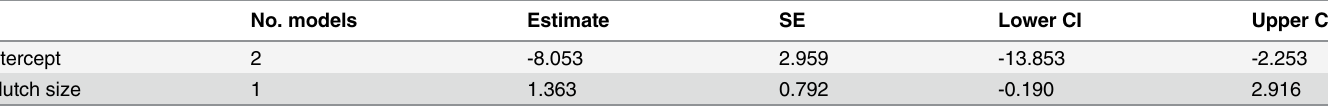
Table 3. Averaged model estimates and 95% confidence intervals from the top models predicting egg stage failure (marginal R 2 = 0.22; conditional R 2 = 0.22); b); c) and d).